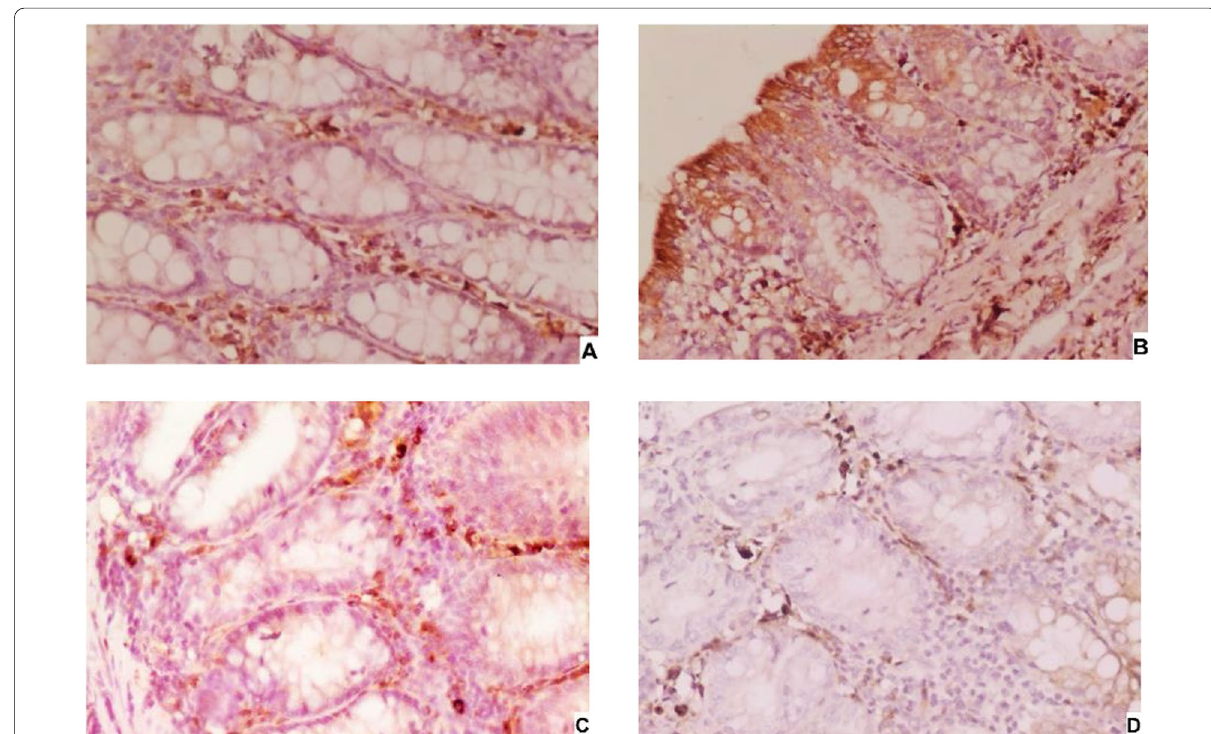
Fig. 6 Photomicrographs of colon sections of different groups immune-stained with Ck20 ( moderate cytoplasmic Ck20 IHC positivity. B : DMH group showed severe Ck20 expression. C : 5FU group presented Ck20 immunoreaction in the mucosal glands. D FA-5FU combined treated rats showing mild Ck20 IHC